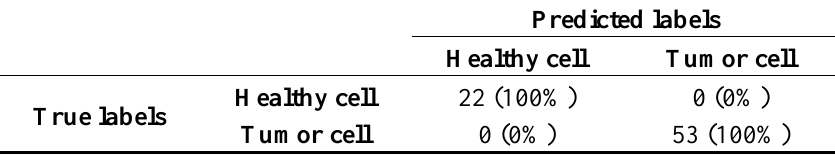
Table 2. Confusion table reduced to a binary classifier relevant for diagnosing the disease to determine true positives (sensitivity: 100%), false positives (0%) and specificity